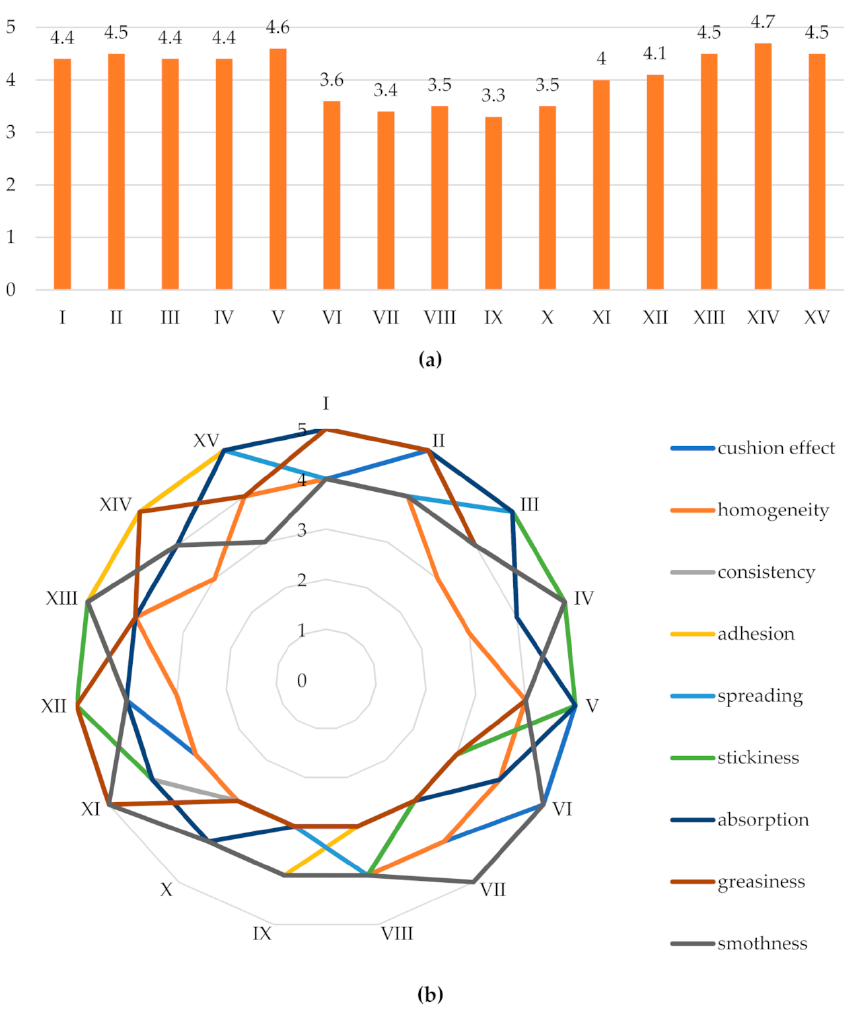
Figure 3. Results of sensory evaluation of the emulsions ( a ) mean scores and ( b ) sensory profile. “1–5“ is a 5-point score